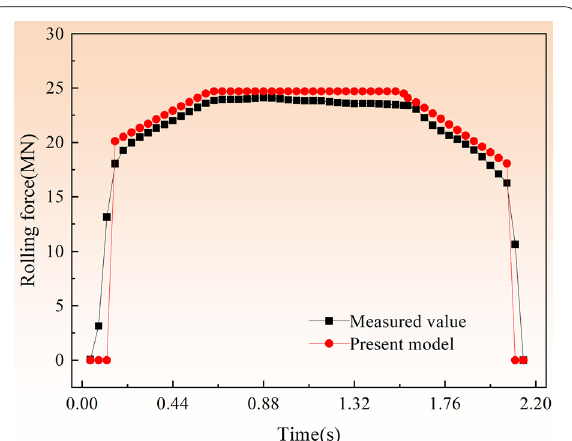
Figure 6 Comparison of roll separating force for theoretical and measured values in MAS rolling